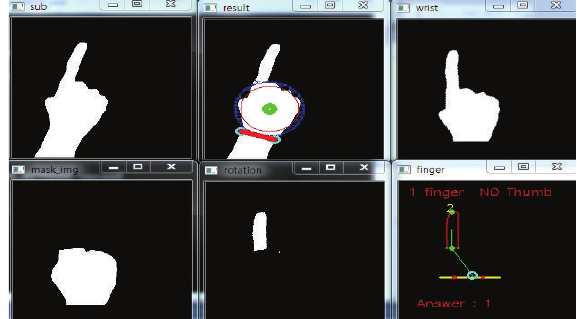
Figure 14: The recognition of the hand gesture 1.